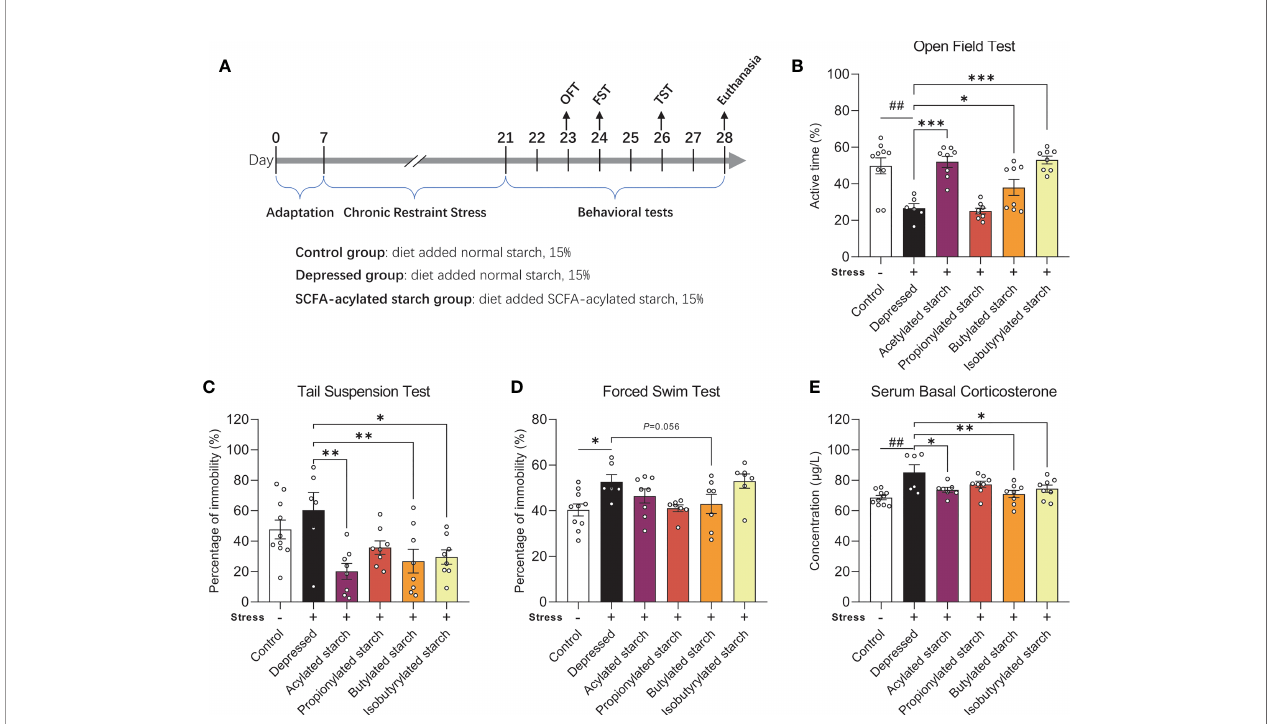
FIGURE 1 | The effect of the SCFA-acylated starches on the neurobehavioral phenotype. (A) The animal experiment schedule. (B) Open fi eld test. (C) Tail suspension test. (D) Forced swim test. (E) Serum corticosterone levels. Except for the control, all groups are given two-week chronic restraint stress. Data are mean with SEM (n=6-10 per group for each test). ## P <0.01 in the unpaired t-tests. * P <0.05, ** P< 0.01, *** P <0.001 in the one-way ANOVA followed by Dunnett ’ s multiple comparisons test against the Depressed